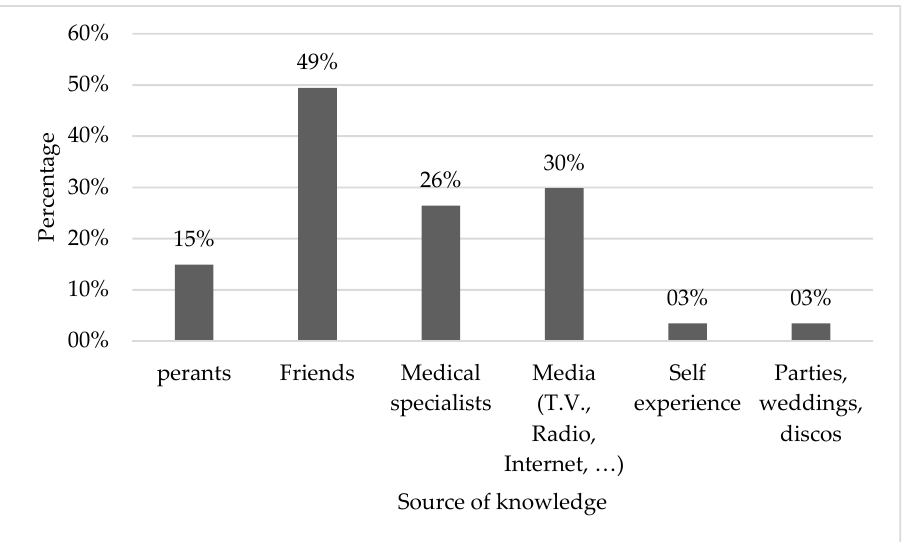
Figure 2. The sources of knowledge about hearing protection and earplug use.